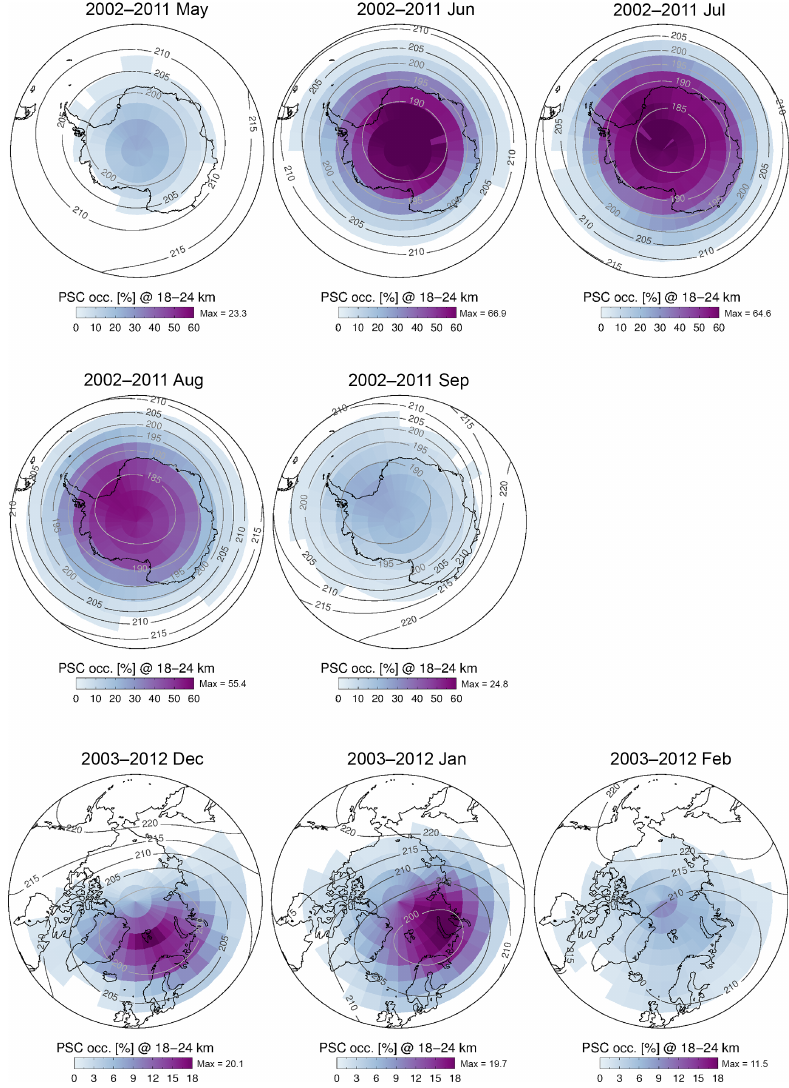
Figure 7. Monthly mean of hemispheric PSC occurrence between 18 and 24km for the months with PSC activity (SH: May, June, July, August, and September; NH: December, January, and February). A mean of 2002–2012 ERAi-based temperature contours at 50hPa is superimposed in grey. Please note the different ranges in the colour code between SH and NH